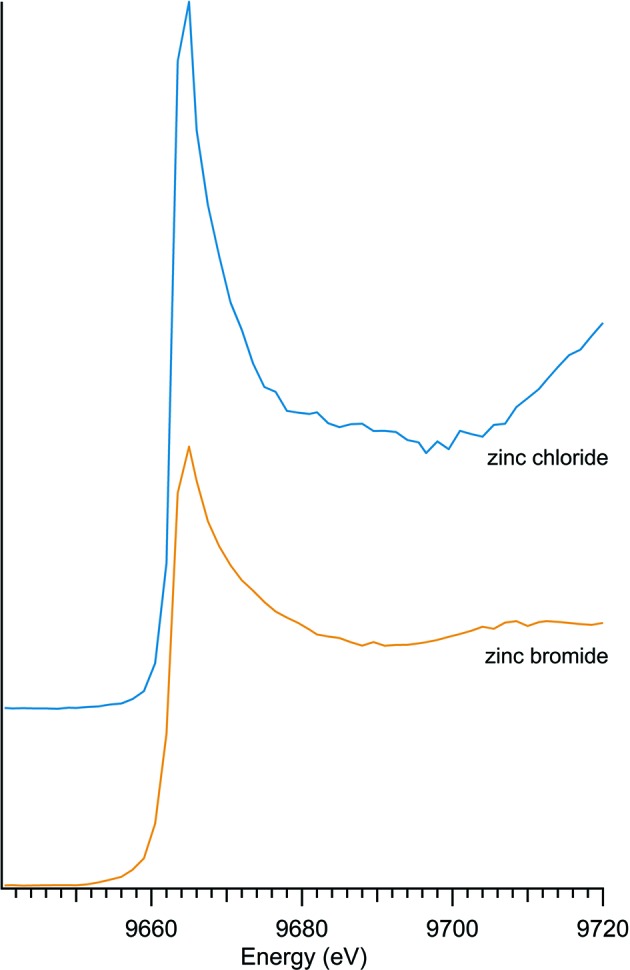
Zinc halogen spectra.